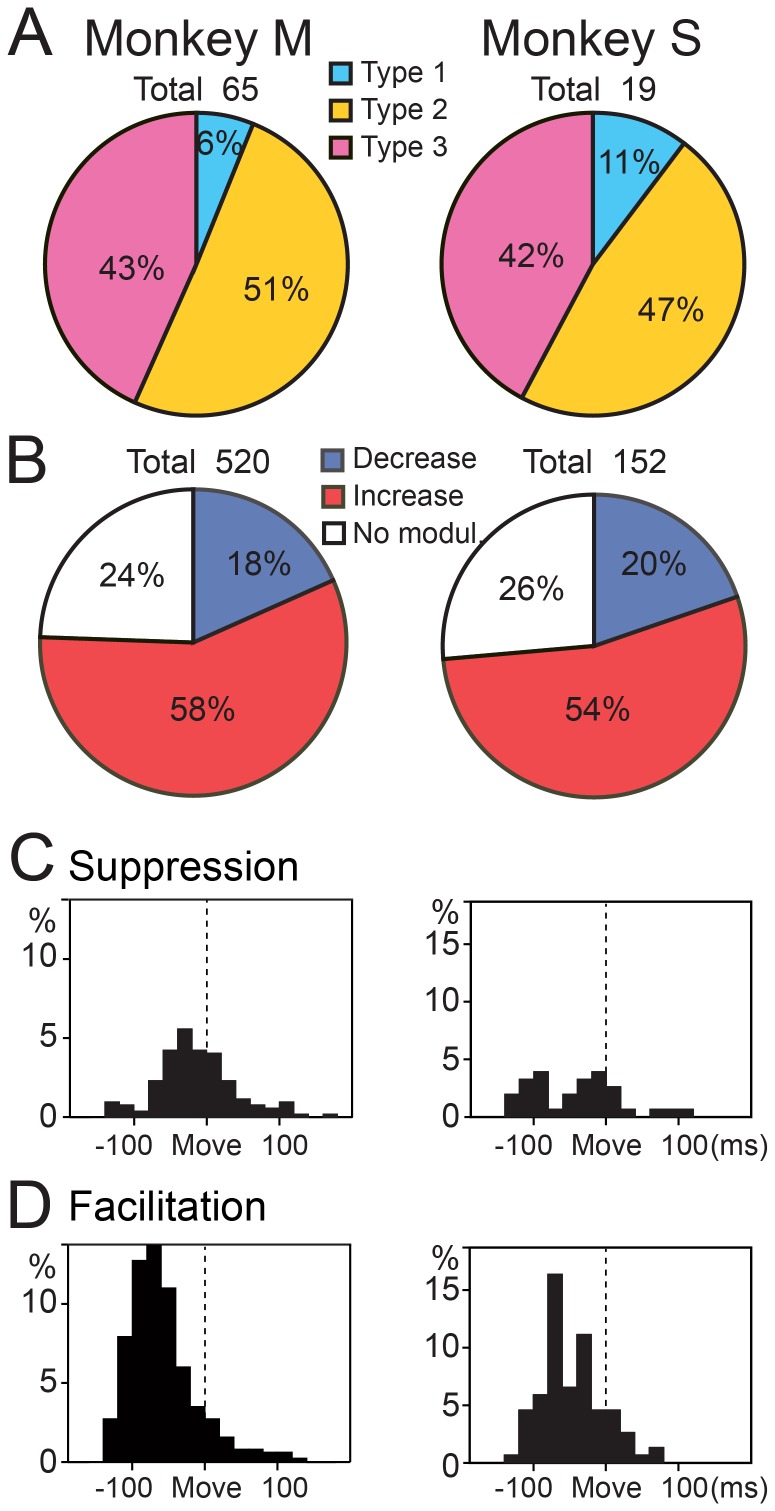
Percentages of the three types of DN cells and distributions of onset latency for all suppressions and facilitations of DN cell activity.A: Percentages of the three types of DN cell activity in the pronated posture in monkeys M and S. ‘Total’ at the top of each pie chart indicates the number of cells. B: Percentages of all facilitations and suppressions among the three types of modulation in the pronated posture in each animal. ‘Total’ at the top of each pie chart indicates the number of data sets (8 directions × number of cells). C and D: Distribution of onset latencies for all suppressions (C) and facilitations (D) recorded in the pronated posture for the two animals. Mean onset latencies were significantly earlier for the facilitations (D) than for the suppressions (C) (see Table 4).